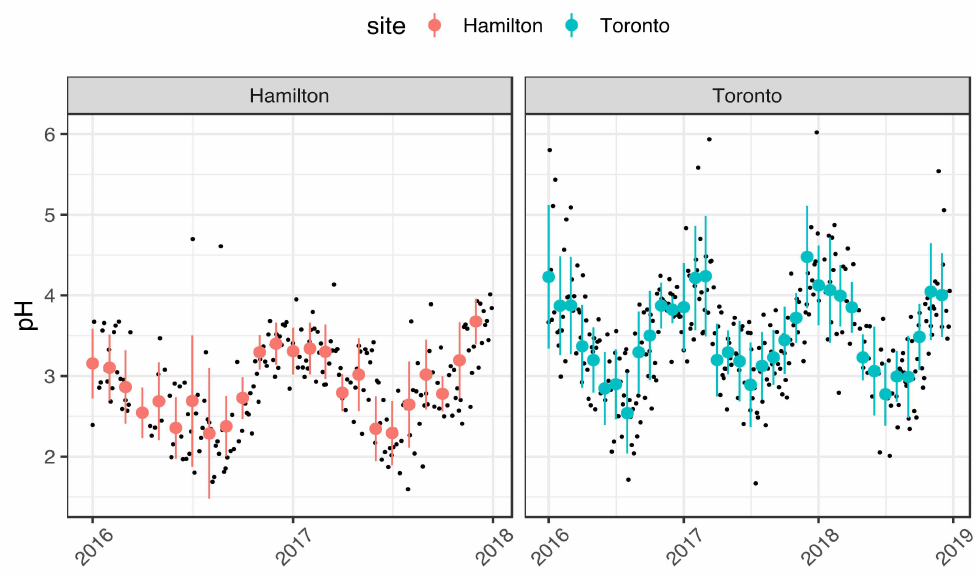
Figure 1. Aerosol pH (black dots) and monthly average pH in Hamilton (red) and Toronto (light blue) over the period of 2016 to 2019. Error bars are standard deviation of monthly pH distribution at the two